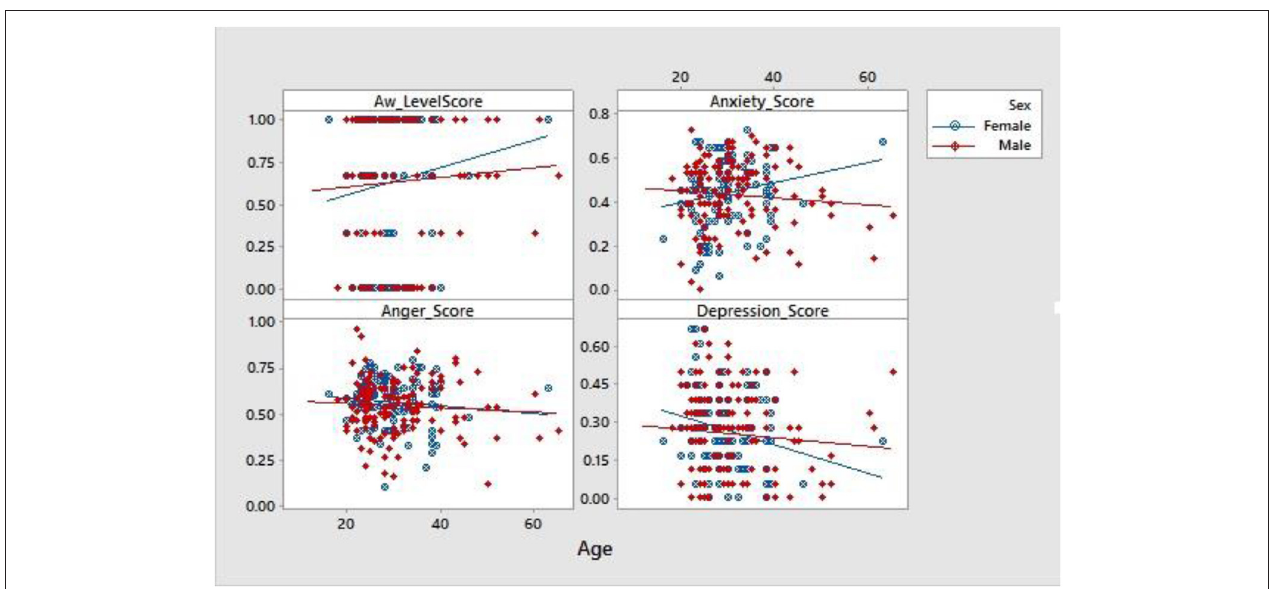
FIGURE 4 | Scatter plot of Sex influence on age associated changes in awareness, anxiety, anger, and depression.